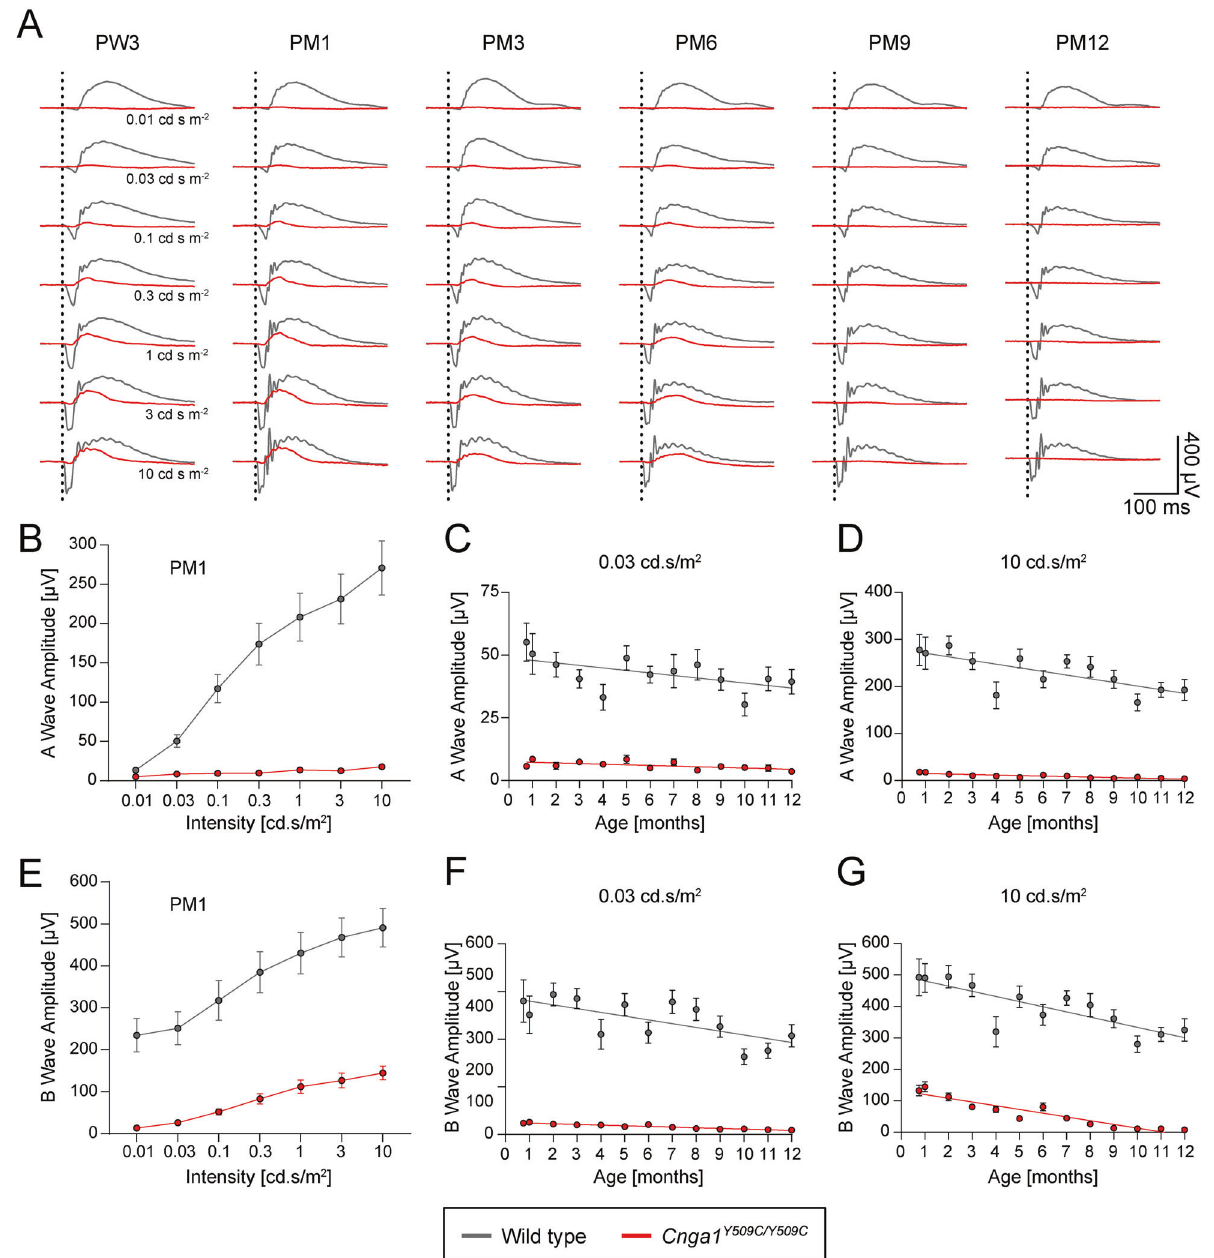
Fig. 5 Cnga1 Y509C/Y509C mice show loss of rod-driven electroretinography. A Overlays of averaged ERG signals of Cnga1 Y509C/Y509C mice (red) compared to wild-type mice (black) at postnatal week 3 (PW3), postnatal month 1 (PM1), PM3, PM6, PM9 and PM12 at different light intensities. Vertical dotted lines mark the time points of light stimulation. Homozygous mutant mice show almost no (rod-mediated) response at low light intensities (0.01 and 0.03 cd s m-2) and also lose cone-mediated response between PM6 and PM9. B – G Quanti fi cation of a-wave and b-wave amplitudes of Cnga1 Y509C/Y509C mice (red) compared to wild-type mice (black) at different ages. a-wave ( B ) and b-wave ( E ) amplitudes were massively reduced in Cnga1 Y509C/Y509C mice compared to wild types for all light intensities at PM1. Rod-mediated responses for the a-wave ( C ) and b-wave ( F ) at a low light intensity (0.03 cd s m-2) as well as cone-mediated response for a-wave ( F ) at a high light intensity (10 cd s m-2) were reduced from the fi rst measurement at PW3, while cone-mediated response for the b-wave ( G ) decreased